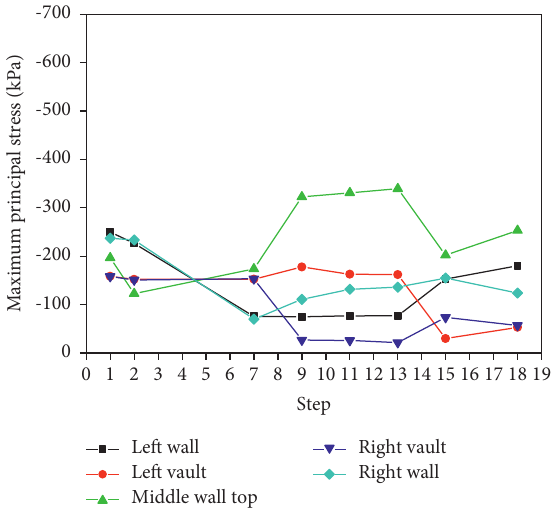
Figure 7: Maximum principal stress of scheme I. Figure 8: Maximum principal stress of scheme